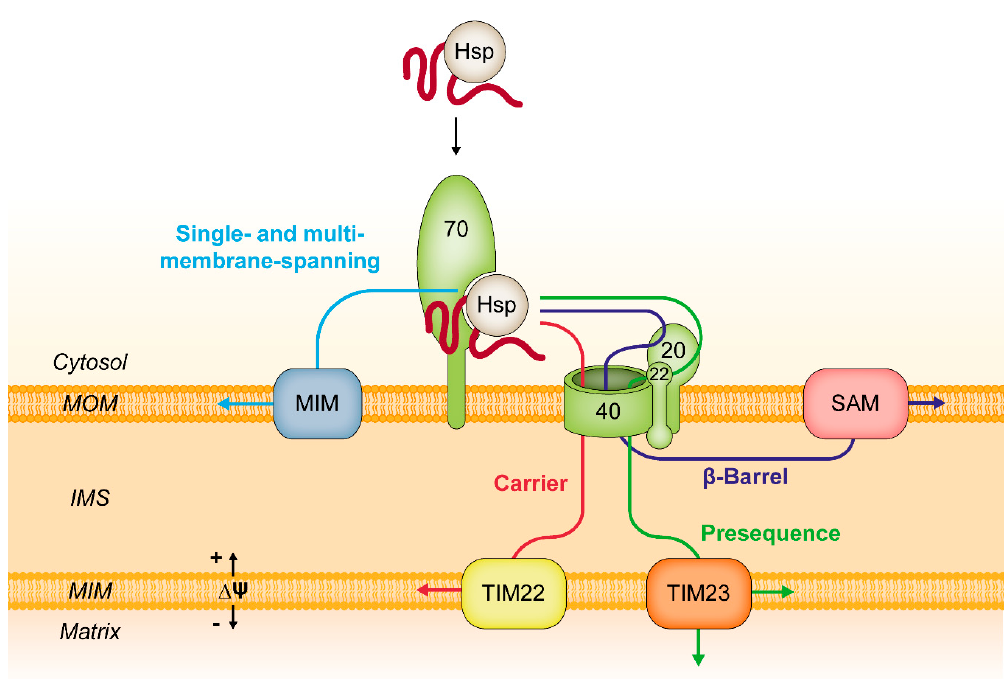
Figure 5. Functions of Tom70 in mitochondrial protein import. Tom70 serves as a docking station for different classes of proteins. Most of these proteins contain hydrophobic domains and are initially associated with chaperone proteins. Tom70 recognizes the chaperone/preprotein complex as a co- import machinery. Carrier proteins are imported through the import pore Tom40 and inserted into the mitochondrial inner membrane by the translocase of the inner mitochondrial membrane (TIM22).